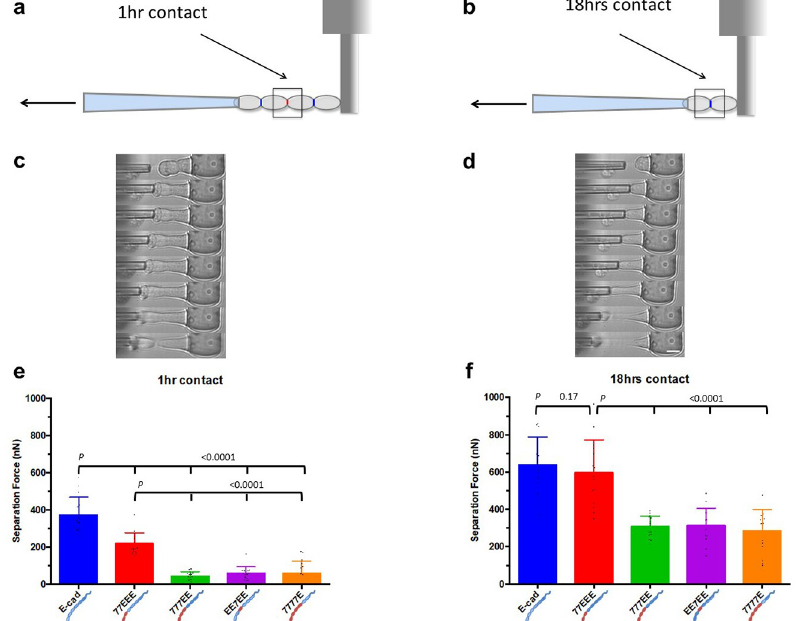
Fig 2. Pillar-pipette assay. (a) Cartoon showing two pairs of pre-existing (18 hrs) doublets adhering to each other through a junction established after 1 hr (red, shown by the square box). The doublets are attached to a pillar tip and are pulled by a micropipette to the left. (b) Once the two pre-existing doublets are separated from each other, the two cells of the pre-existing doublet with the intact junction (blue, shown by the box) still attached to the pillar are separated. (c) Representative kymograph from E-cad group showing two pre-existing doublets adhering to each other through a 1-h contact, and the 4-cell complex attached to a pillar tip. Note the deflection in pillars as the cells are pulled by the pipette. (d) Representative kymograph from E-cad group showing a pre-existing doublet with a mature contact and attached to a pillar tip. Scale bar, 15 μ m. (e) Histogram showing the separation force (SF) for cells expressing wild- type E-cad and chimeric cadherins at 1 hr cell-cell contact ( n = 15 each). (f) Histogram showing the SF for pre-existing (18 hrs) doublets expressing wild-type E-cad and chimeric cadherins (E-cad, n = 15; 77EEE, n = 15; 777EE, n = 14; EE7EE, n = 14; 7777E, n =